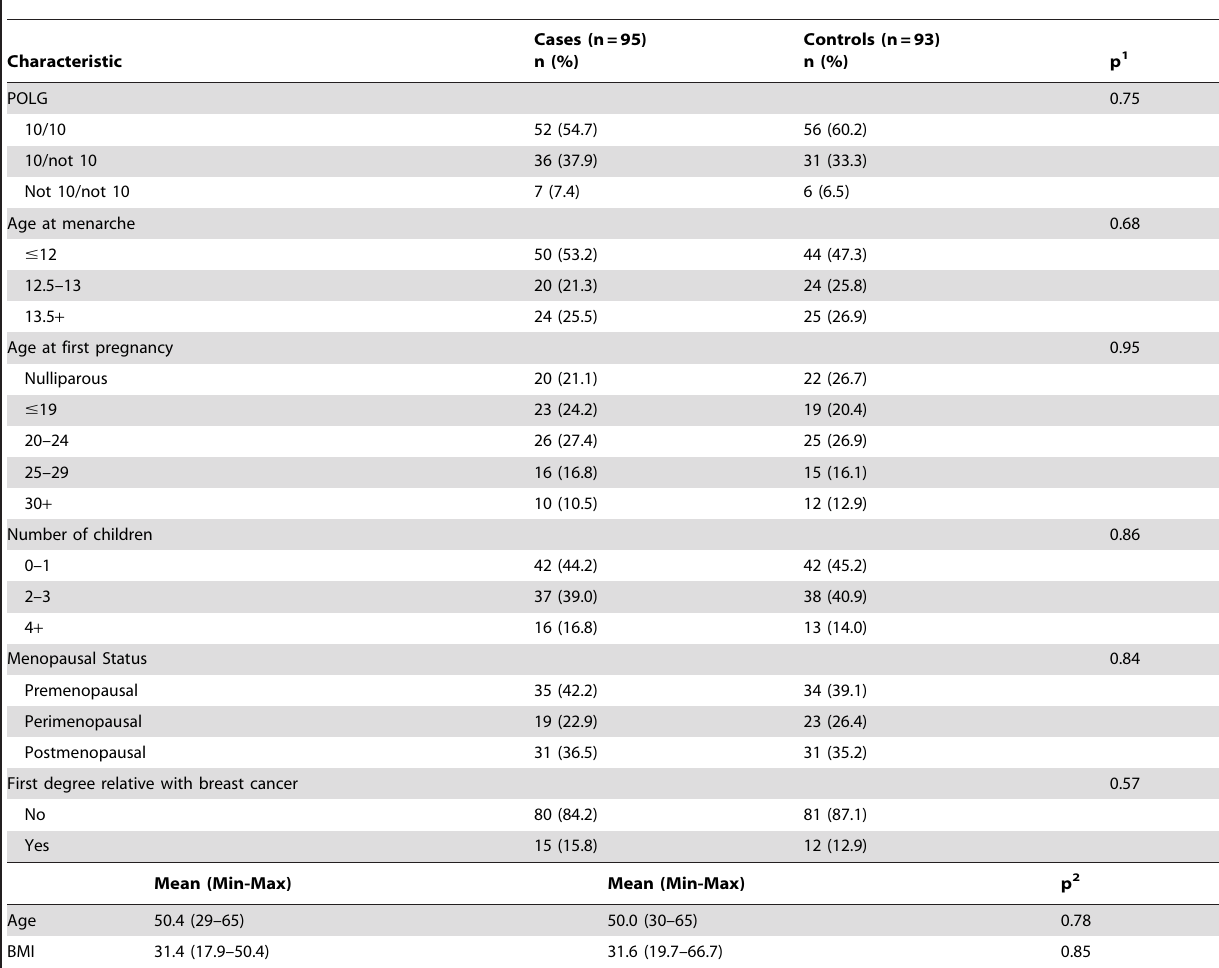
Table 1. Selected characteristics of Cases and Controls in WCHS with POLG-CAG repeat polymorphism.